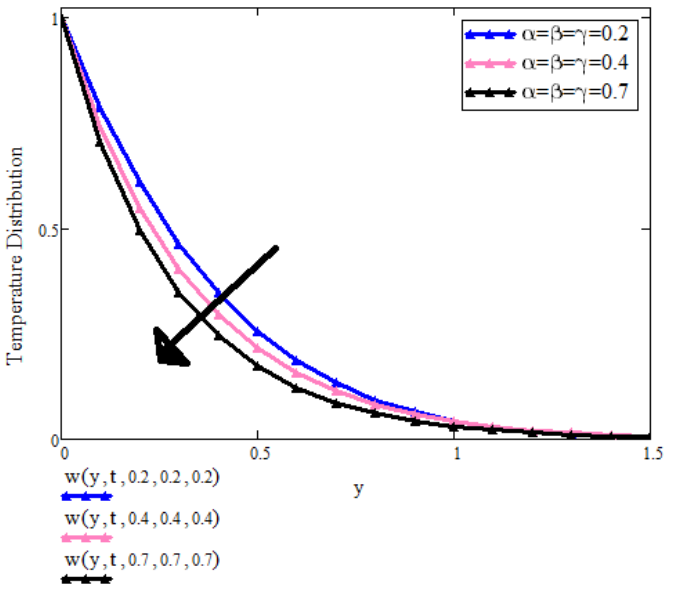
Figure 2. T ( y , t ) with α , β , γ when t = 0.8, a = 0.9, λ = 0.5, Pr = 6.2, β 1 = 0.9, φ 1 = φ 2 = φ 3 = 0.03. Figure 3 is showing the influence of the concentration of nanoparticles φ 1 , φ 2 , φ 3 on the